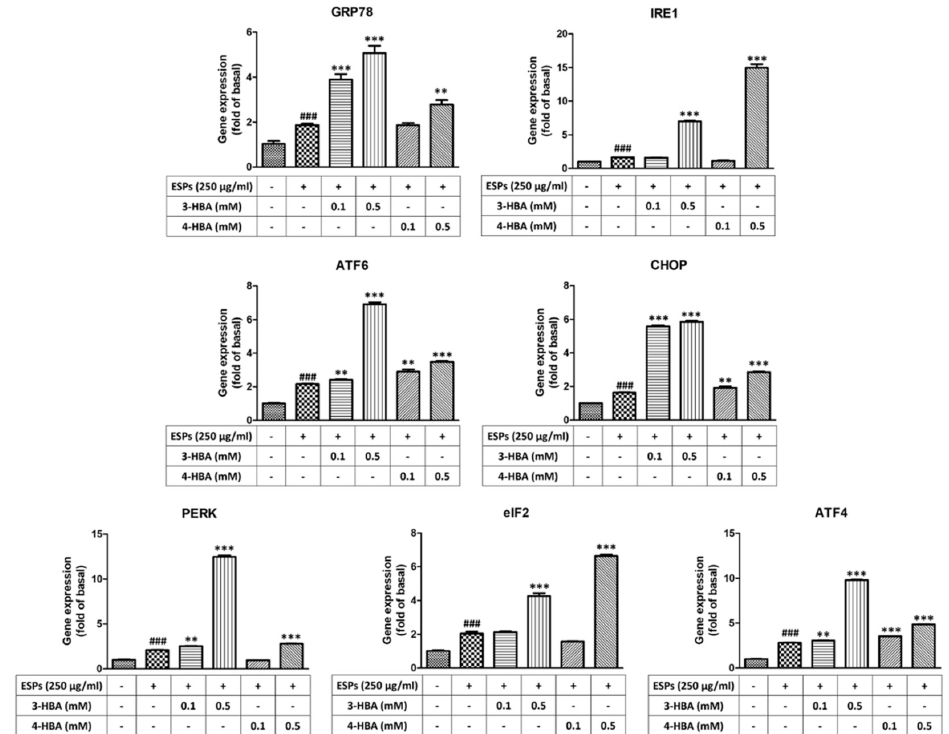
Figure 3. 3-HBA and 4-HBA induce the expression of ER stress-related genes in ESP-treated astrocytes. Cells were pretreated with 3-HBA and 4-HBA (0.1 and 0.5 mM) for 4 h and then incubated with 250 µ g/mL ESPs for 12 h. mRNA expression was determined by real-time qPCR ( n = 3). + and - represent cells were pretreated or not with ESPs, 3-HBA or 4-HBA. ### p < 0.001, compared to control. ** p < 0.01, *** p < 0.001, compared to cells exposed to